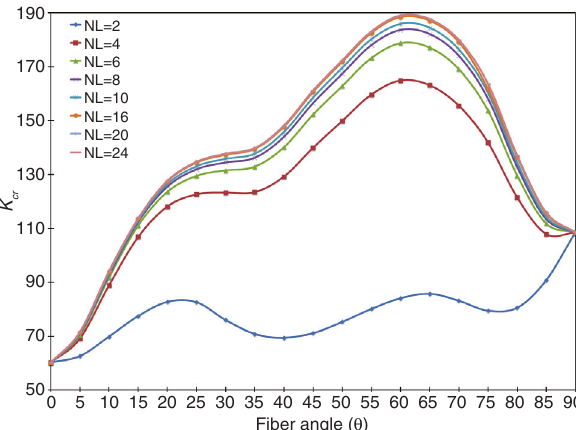
Figure 17 Critical buckling load parameter for clamped antisym- metric cylindrical skew panel (Ø = 30 ° , α = 30 ° ).